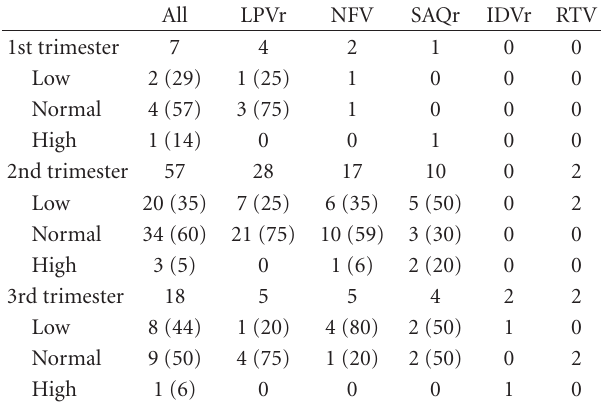
Table 3: Distribution of therapeutic drug monitoring results of protease inhibitors during